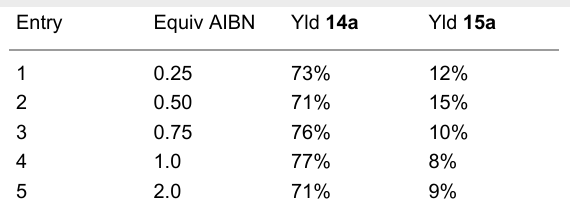
Table 2: Effect of AIBN Concentration on Product Yields in Reaction of 11a a